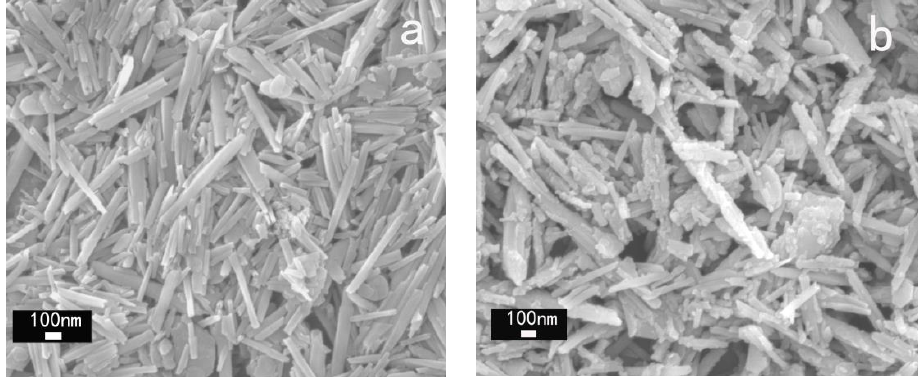
Figure 4. SEM images of ( a ) P-HNTs and ( b ) KT-HNTs.